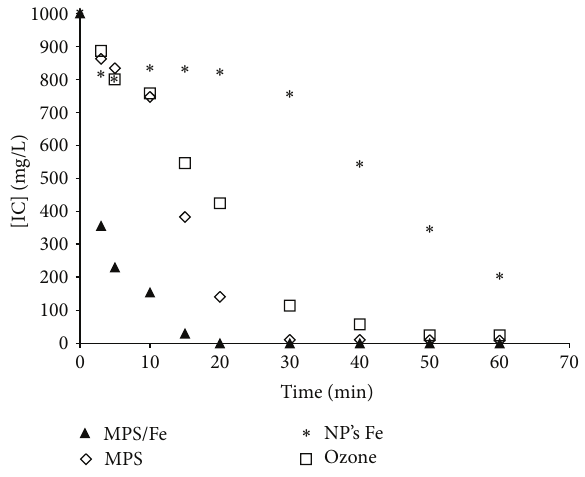
Figure 3: Effect of the material and time on IC concentration [ { ] supported on deoiled allspice husk (MPS/Fe), [ ⬦ ] deoiled allspice husk (MPS), [ ∗ ] iron metal particles (NP-Fe), and [ ◻ ] indigo carmine (IC) only